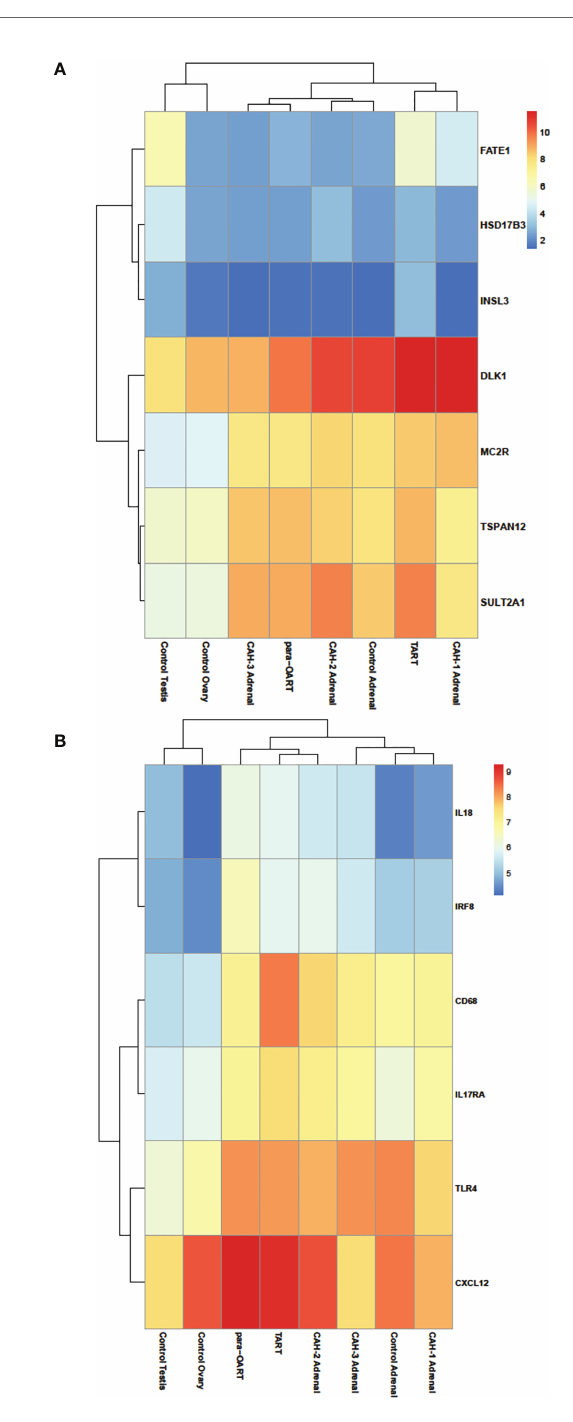
FIGURE 4 | Heatmap illustrating differential RNA-seq expression data in ART, CAH adrenals and control tissues. Heatmap showing relative log-transformed expression levels of (A) adrenal enriched- ( DLK1, MC2R, TSPAN12, SULTA1 ), gonadal enriched- ( FATE1, HSD17B3, INSL3 ) markers, and (B) genes speci fi c to in fl ammation and immune response ( IL18, IRF8, CD68, IL17RA, TLR4, CXCL12 ). Red color indicates relatively higher number of transcripts and blue color indicates relatively lower number of transcripts based on normalized read counts.